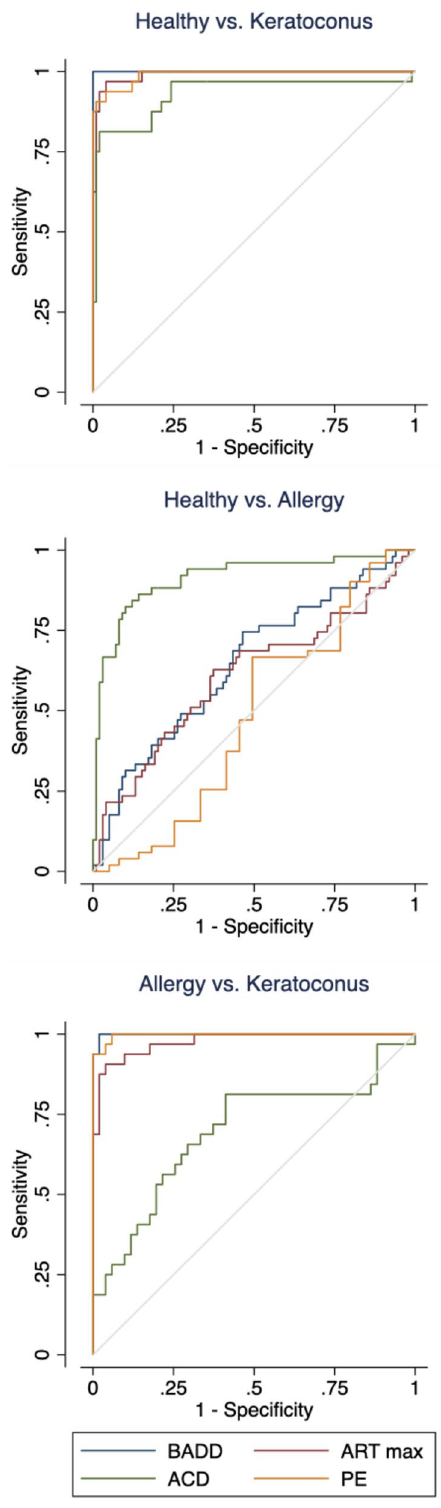
Figure 2. Combined receiver operator curves for BAD-D, ARTmax, ACD, and PE in comparisons between controls and keratoconus patients, controls and ocular allergy patients, and ocular allergy and keratoconus